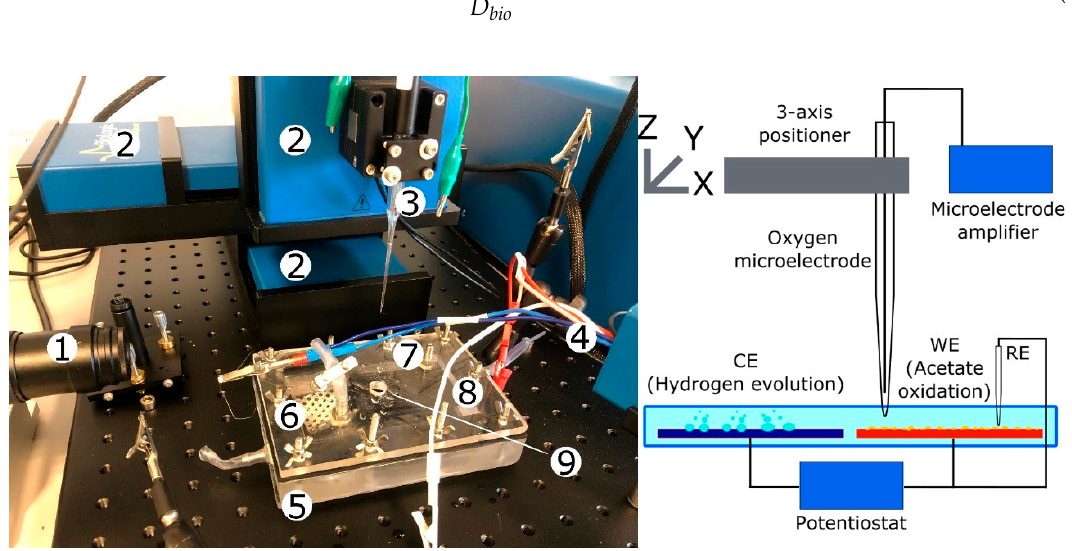
Figure 5. Experimental set-up: camera ( 1 ); three-axis micropositioner ( 2 ); microelectrode ( 3 ); connections to the potentiostat ( 4 ); methacrylate cell ( 5 ); counter electrode (CE) ( 6 ); reference electrode (RE) adapter ( 7 ); working electrode (WE) ( 8 ); and microelectrode sampling hole ( 9 ).